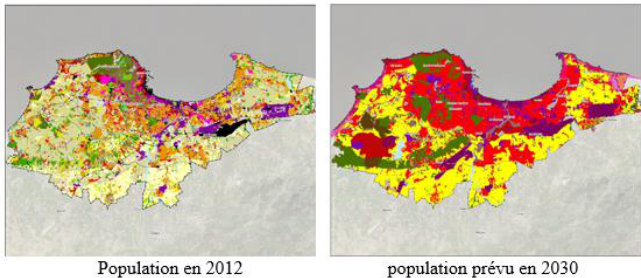
Figure 2. Evolution of the population. Source: TSO EGIS The population is the intervening variable in any projections, also considered as a source of